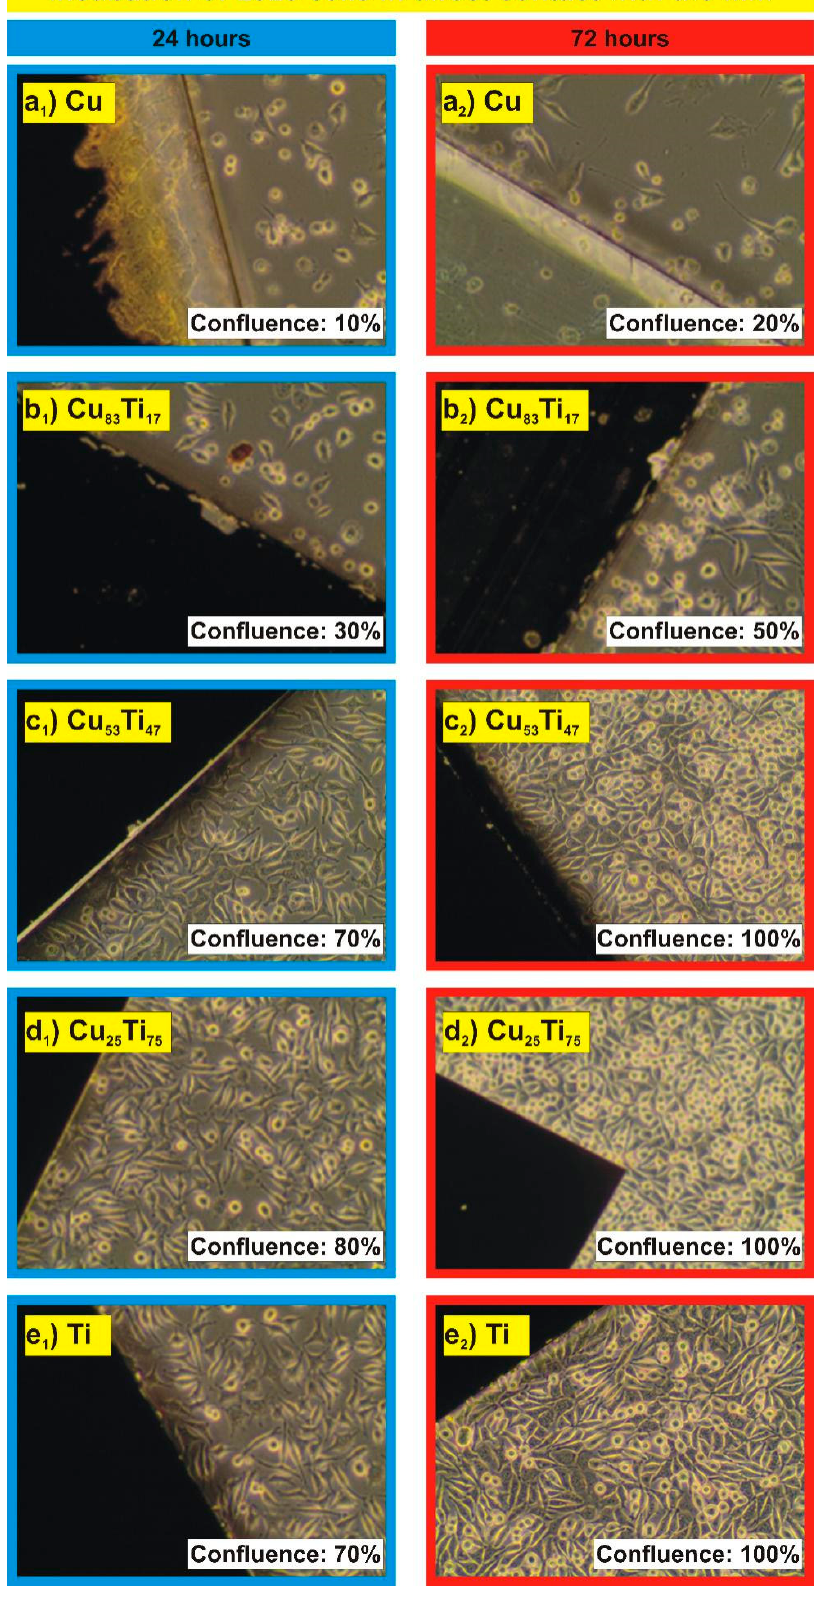
Figure 8. Microscopic photographs of the degree of confluence and changes in the morphology of L929 cells in direct contact with thin films based on Cu and Ti after 24 and 72 h of